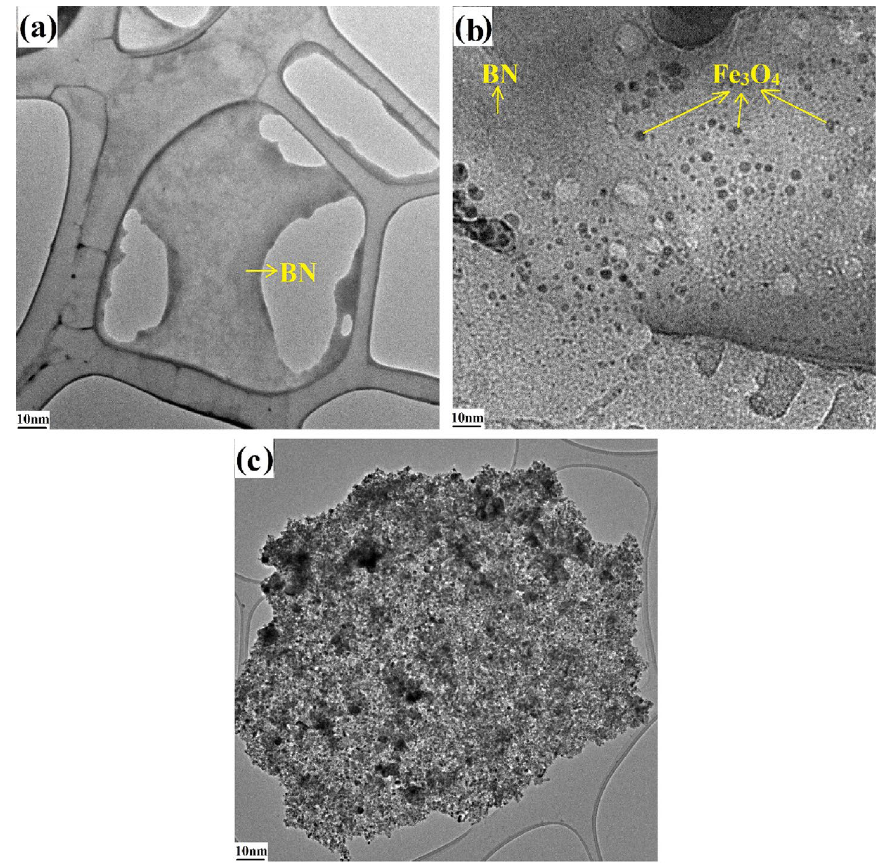
Figure 2. TEM images of the ( a ) BN, ( b ) appropriate BN–Fe 3 O 4 nanostructure and ( c ) inappropriate BN–Fe 3 O 4